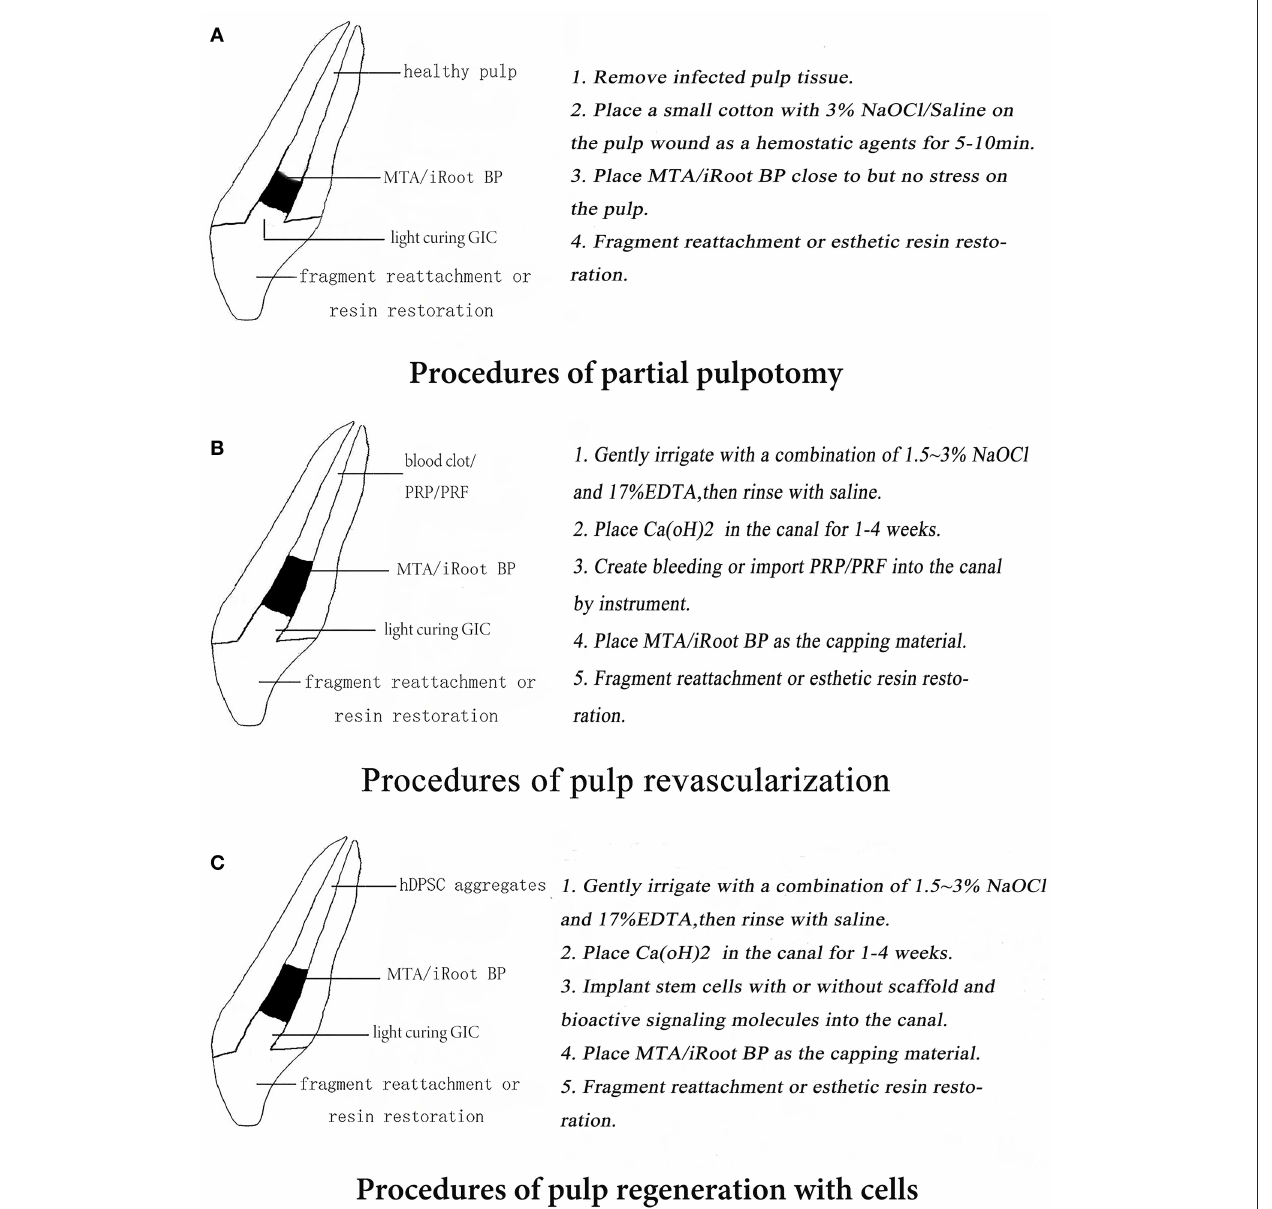
FIGURE 1 | (A–C) Patterns of three regenerative endodontic procedures (REPs) in immature permanent teeth